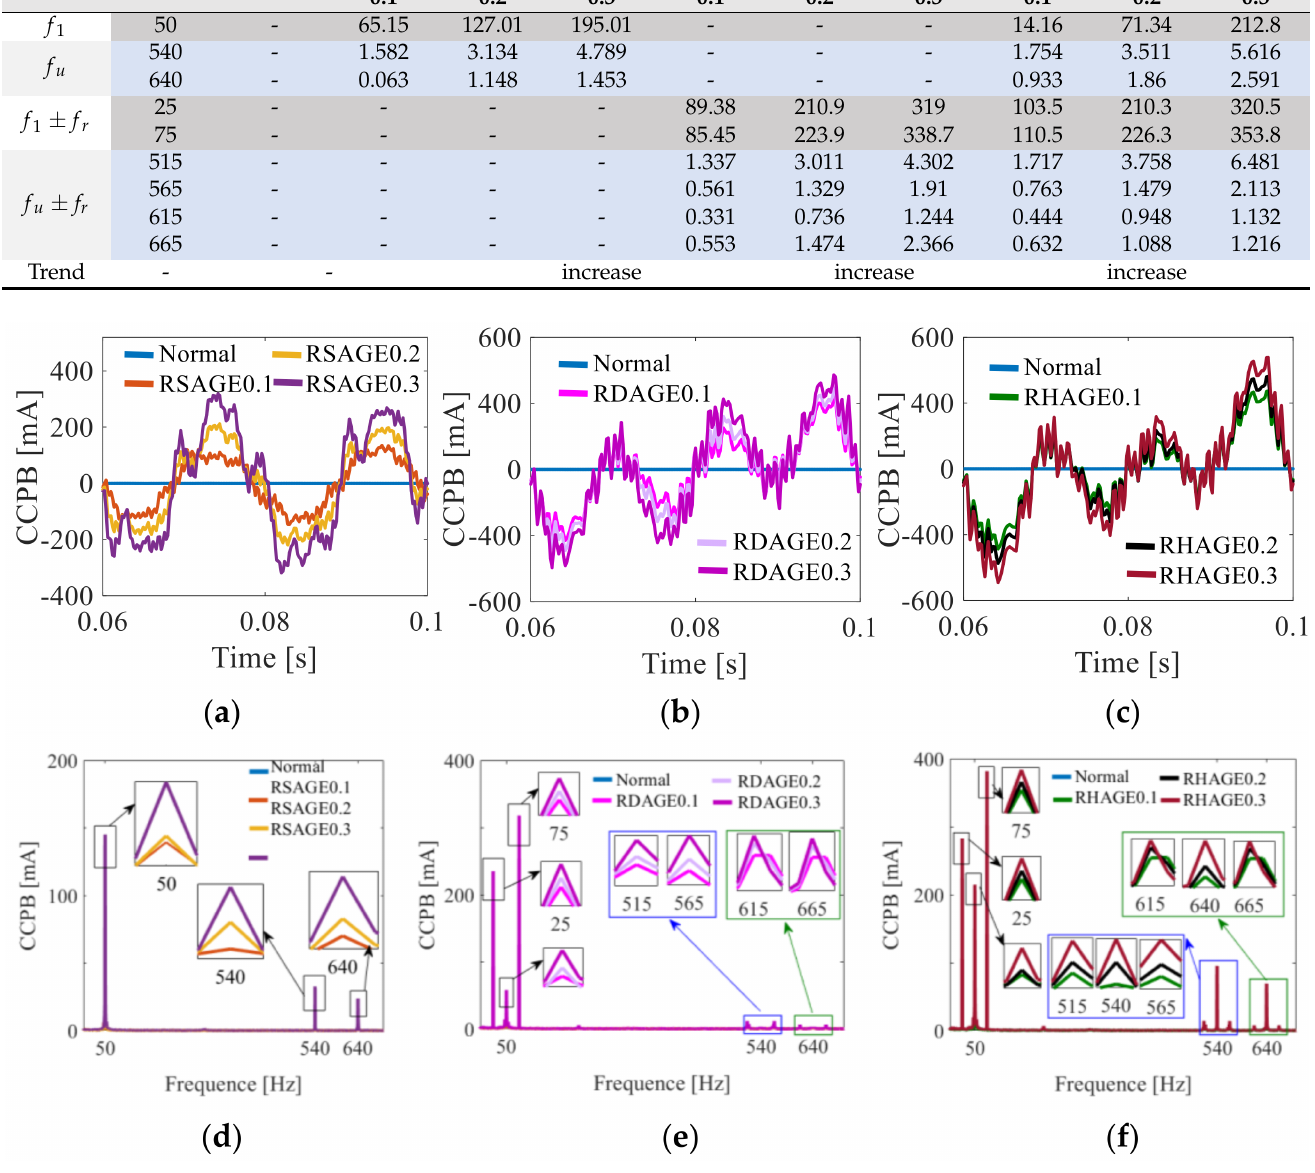
Figure 9. The stator CCPB in normal and RAGE conditions: ( a ) the time domain of stator CCPB in RSAGE; ( b ) the time domain of stator CCPB in RDAGE; ( c ) the time domain of stator CCPB in RHAGE; ( d ) the frequency domain in RSAGE; ( e ) the frequency domain in RDAGE; ( f ) the frequency domain in